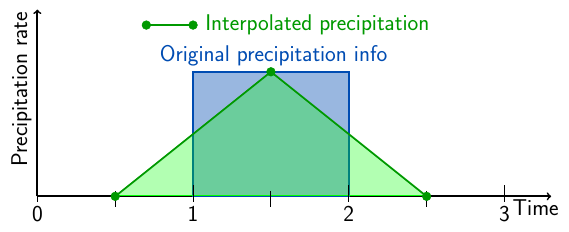
Figure 2. Example of so-called “disaggregation” of precipitation data for the use in FLEXPART as currently implemented, with the case of an isolated precipitation period. Note that the supporting points for the interpolation now coincide with the times when other meteorological fields are available. Colours are used as in Fig.